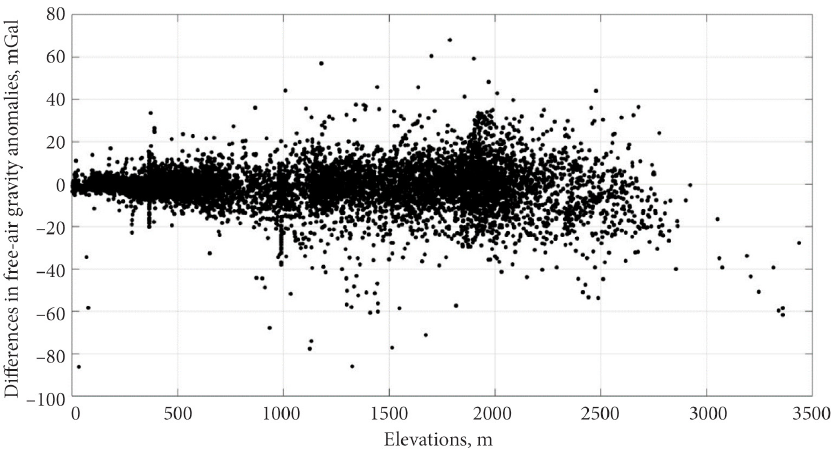
Figure 4. Differences between observed and EIGEN-6C4 implied free-air gravity anomalies over Kenya as a function of terrain elevation at 8,690 gravity data points